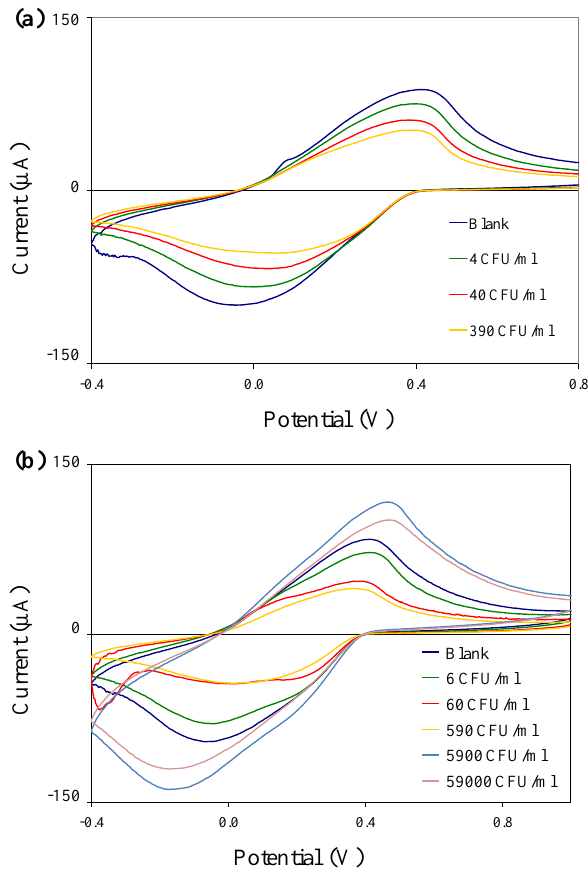
Figure 5. Cyclic voltammograms of immuno-c/sNP-cell solutions: ( a ) B. cereus cell concentrations ranging from 4 to 3.9 × 10 2 CFU/mL; and ( b ) E. coli O157:H7 cell concentrations ranging from 6 CFU/mL to 5.9 × 10 4